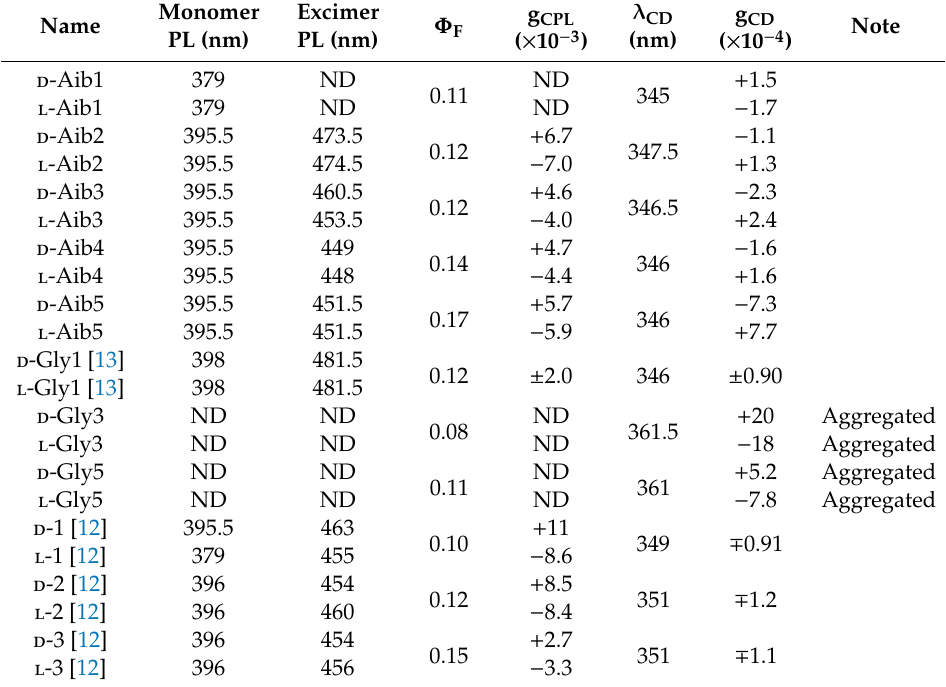
Table 1. CPL, PL, circular dichroism (CD), and UV–Vis properties of peptide-pyrene luminophores in CHCl